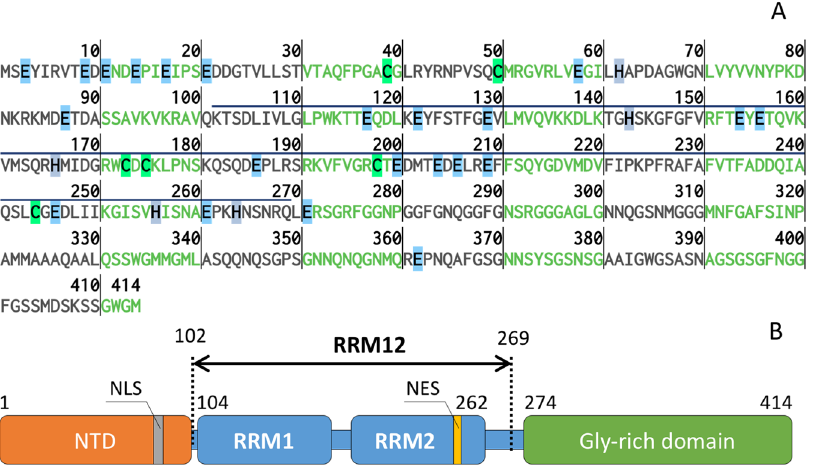
Figure 1. ( A ) Amino acid sequence of Transactive response DNA-binding protein 43 (TDP-43). The fragment of 102–269 (RRM12) used in this study is overlined. The amino acids, which are able to chelate zinc ions are highlighted: in light blue – Glu, in green – Cys and in grey – His. Image was generated using Protein Sequence Analysis Tool 54 . ( B ) Domain organization of TDP-43: NTD – N-terminal domain; NLS – nuclear localization signal; RRM1 (106–177 a.a.) and RRM2 (192–259 a.a.) – RNA-recognition domains; NES – nuclear export